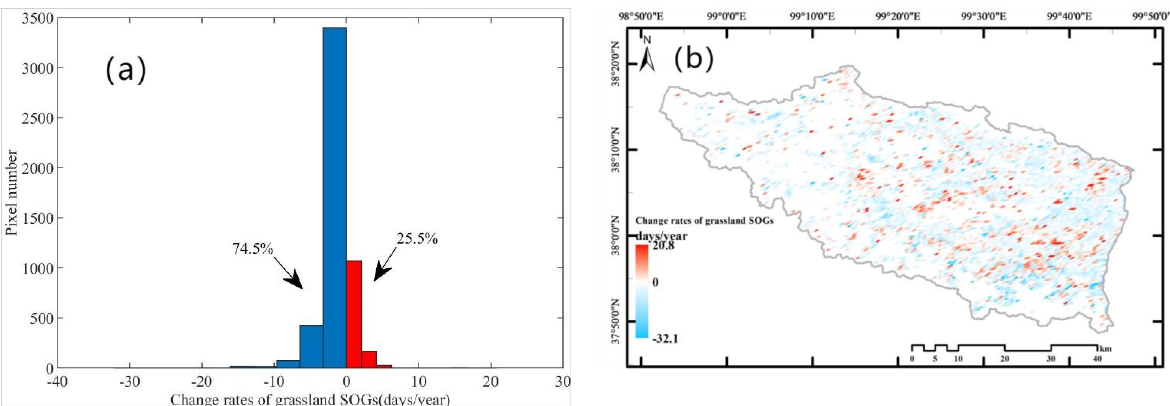
Figure 9. ( a ) SOG annual rate of change; ( b ) change rates of grassland SOG in the Muli region from 2014 to 2021.